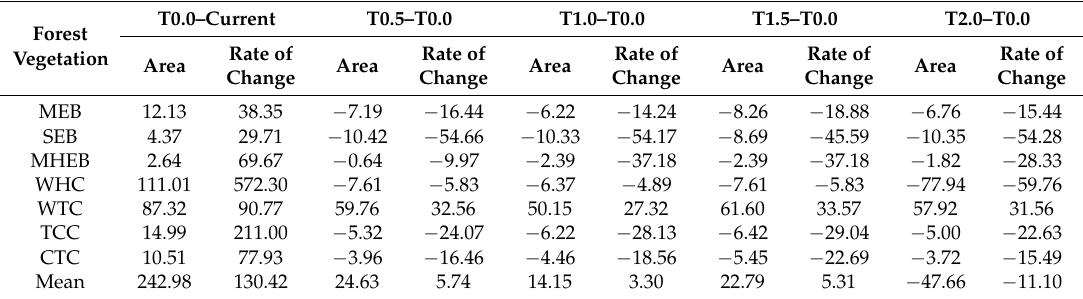
MEB: Monsoon Evergreen Broad-leaved Forests; SEB: Semi-humid Evergreen Broad-leaved Forests; MHEB: Mountainous Humid Evergreen Broad-leaved Forests; WHC: Warm-hot Coniferous Forests; WTC: Warm-temperate Coniferous Forests; TCC: Temperate-cool Coniferous Forests; CTC: Cold-temperate Coniferous Forests